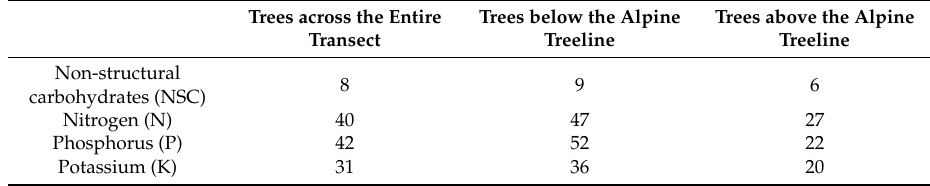
Table 5. Mean end-season reallocation rate (%) of resources (NSC, N, P, K) from leaves to other tissues in Betula ermanii trees grown at higher elevations (2107 and 2187 m a.s.l.) and lower elevations (1700, 1800, 1900, and 2027 m), separated by the alpine treeline located at 2030 m a.s.l. on the Changbai Mt., northeastern China. Trees across the Entire Trees below the Alpine Trees above the Alpine Transect Treeline